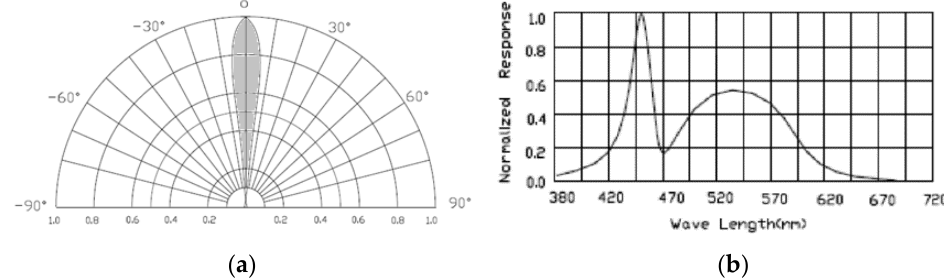
Figure 2. LED characteristic. ( a ): Relative luminous intensity, ( b ): Spectral distribution.